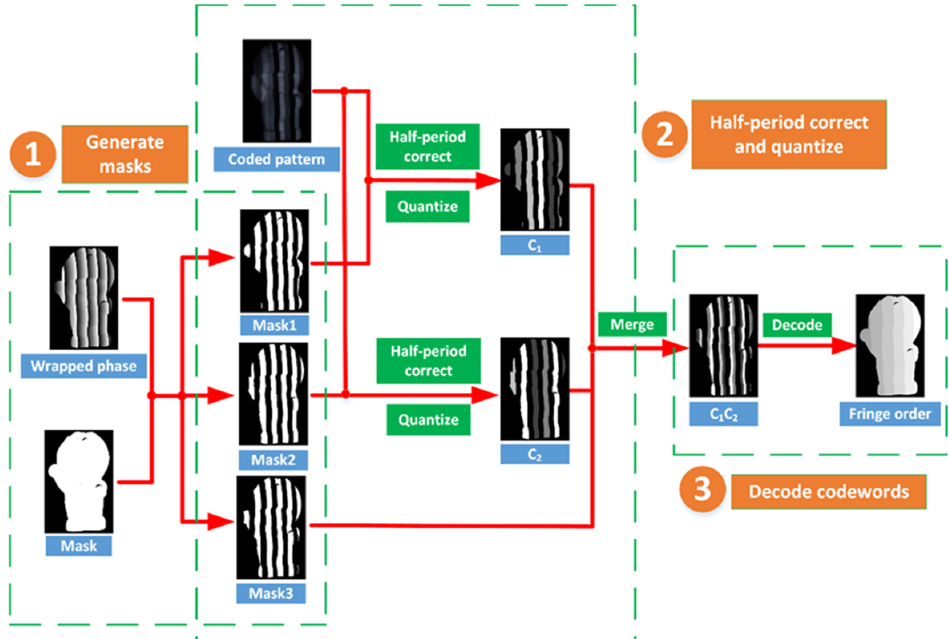
Figure 3. The procedure of the unwrapping strategy.